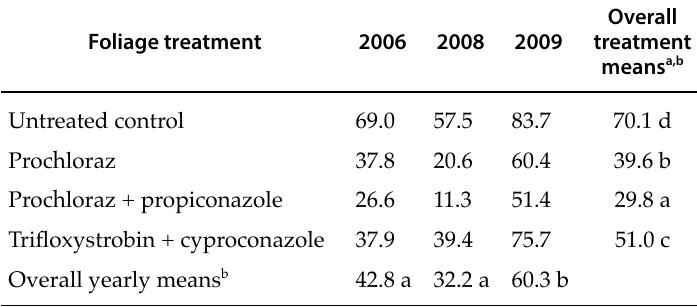
Table 4. Mean eyespot indices (0‒100) for wheat plants in plots treated with different fungicides during three growing sea - sons. Disease severity was assessed in plants collected at ZGS 79‒80 each year. Percentage values were angular transformed before statistical analysis, but non-transformed means are presented here. Each datum is the mean of four replicates. Foliage